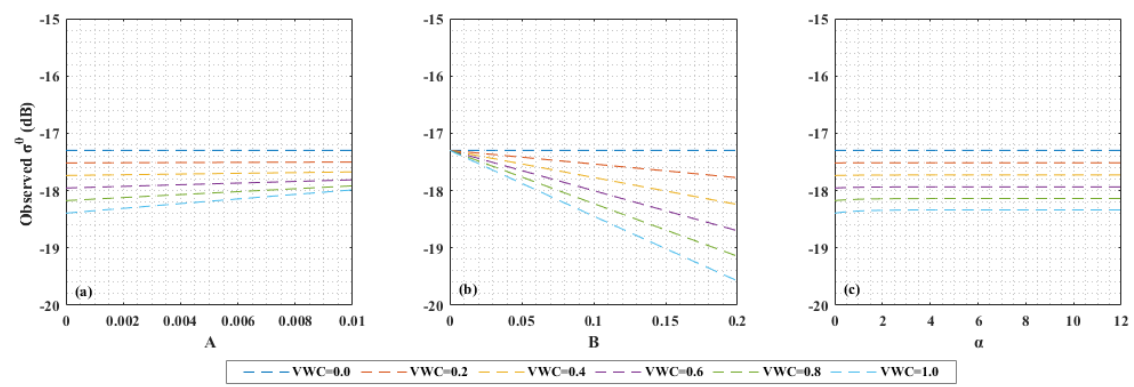
Figure 8. Response of SAR backscatters to variation of vegetation parameters ( a ) A, ( b ) B, and ( c ) α in WCM.